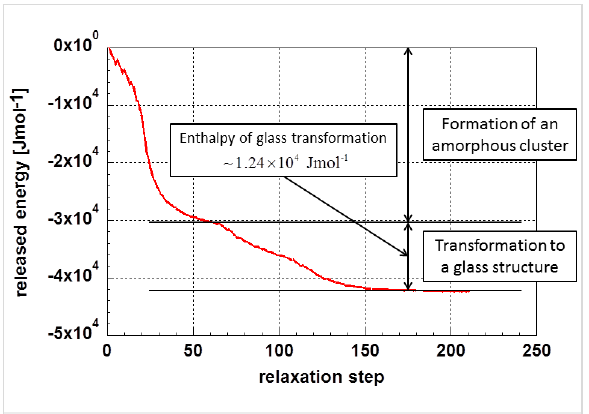
Figure 3: Energy release during relaxation of a random ensemble forming a cluster as function of the relaxation steps.